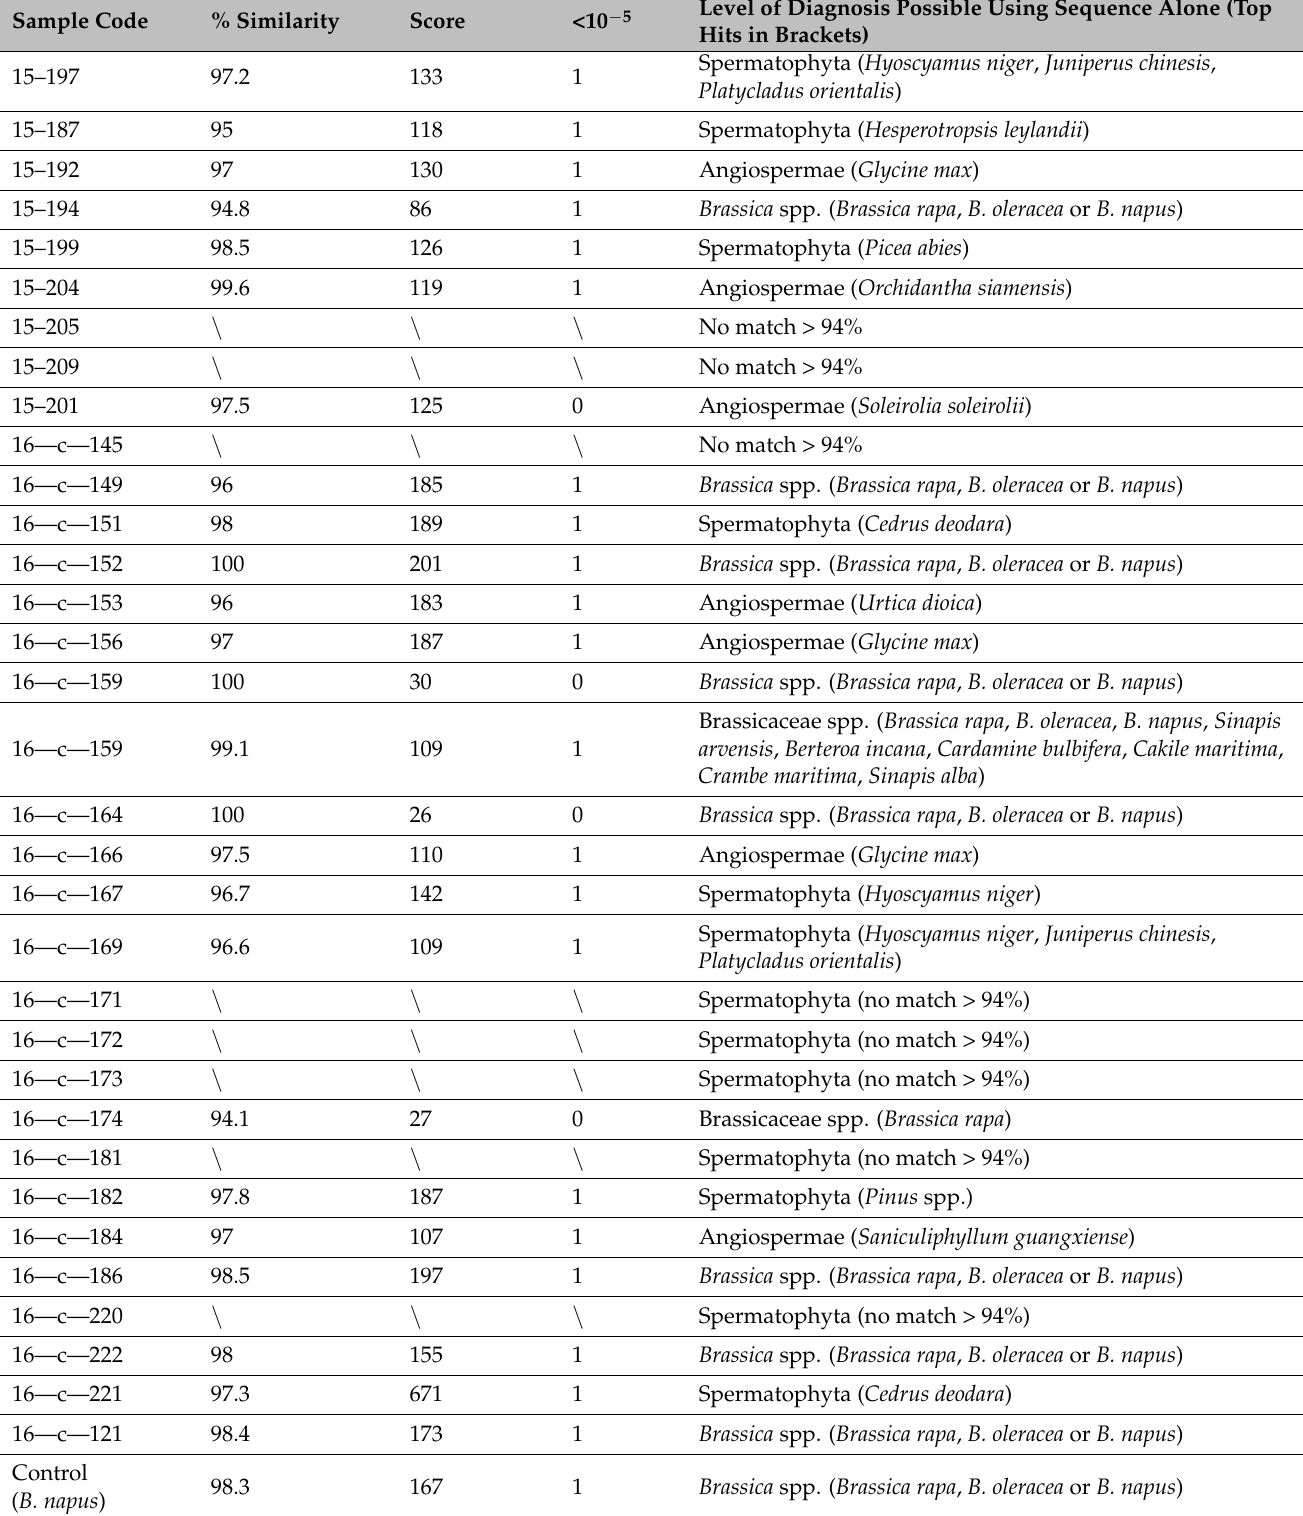
Table 2. Taxonomic diagnosis using rbcL . Best match results recovered on BOLD Systems v4 database using amplicon sequences of rbcL recovered from the study sites. The percentage sequence identity and similarity score are shown, along with whether the probability of a match was lower than 10 − 5 . The final column indicates the level of diagnosis possible using the sequence data alone and the species sharing the highest